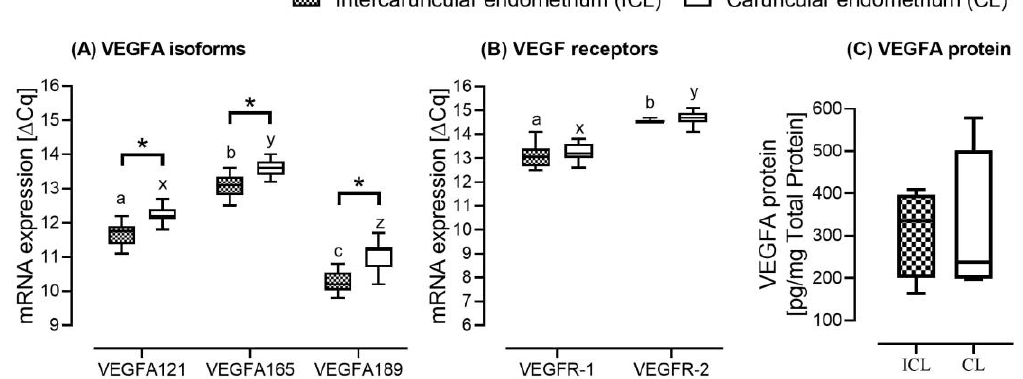
Figure 3. Day 15 post insemination vascular endothelial growth factor A (VEGFA) isoforms ( A ), VEGF receptors ( B ) mRNA expression and protein abundance ( C ) in the intercaruncular endometrial (ICL) and caruncular endometrial (CL) tissues in pregnant Angus heifers ( n = 12). Asterisk (*) indicates significant differences between tissues (intercaruncular vs. caruncular) for the respective genes and letters significant differences in mRNA expression within the intercaruncular endometrium (a,b,c) and the caruncular endometrium (x,y,z) when comparing the genes. Significant differences p < 0.05.